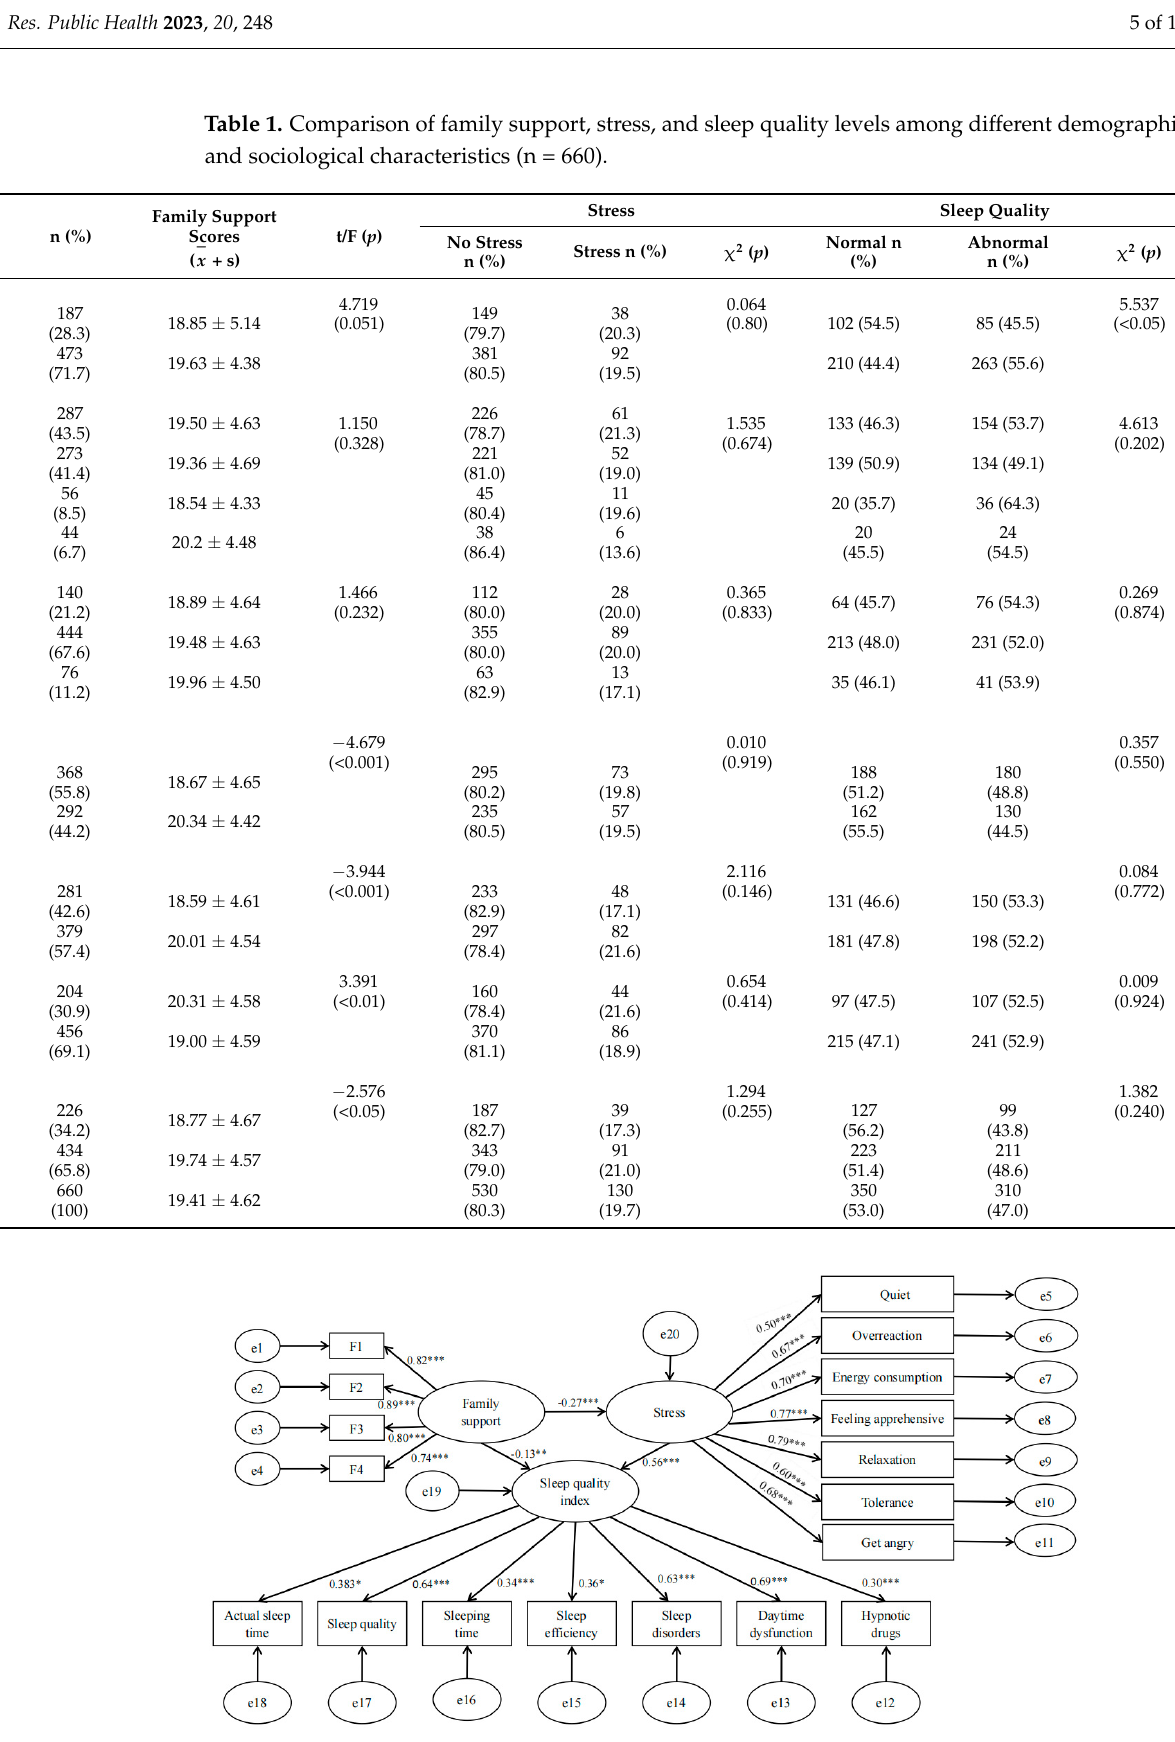
Figure 1. Structural equation model diagram of family support, stress, and sleep quality index. Note